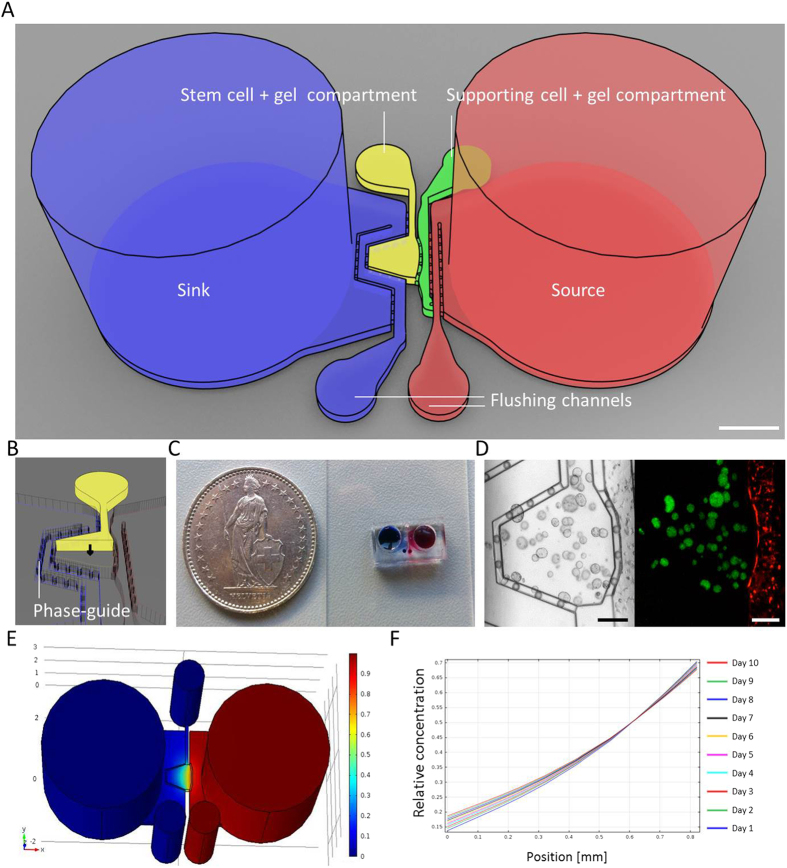
Design and characterization of the microfabricated platform.(A) Schematic representation of the microfabricated device. The device is composed of single or multiple cell-laden hydrogel compartments flanked by two open reservoirs. The scheme shows the device with two chambers. Scale bar indicates 1 mm. (B) Compartments are delimited by phase-guiding features that enable independent loading without spillage. (C) The two reservoirs can be used as source (red) and sink (blue) of a molecule of interest. The molecule will diffuse from the source to the sink while forming gradual distribution within the hydrogel chamber. (D) Multiple compartments allow for patterned co-culture of multiple cell types. Rex1::GFP mouse embryonic stem cells (green) and tomato reporter fibroblasts (red) were co-cultured for 3 days. Scale bars indicate 200 μm. (E) Computational simulation of molecule distribution in the microfabricated device with a single chamber. Simulation was performed with dedicated software (COMSOL Multiphysics, COMSOL AB). The device model was reasonably simplified, and molecular diffusivity in hydrogel was assumed to be equivalent to 0.4 relative to diffusivity in aqueous solution. (F) Simulative quantification of molecule distribution across the hydrogel compartment from day 1 to day 10. The estimated fold changes between the two extremities of the chamber were 5.1 and 3.6 at day 1 and day 10, respectively.